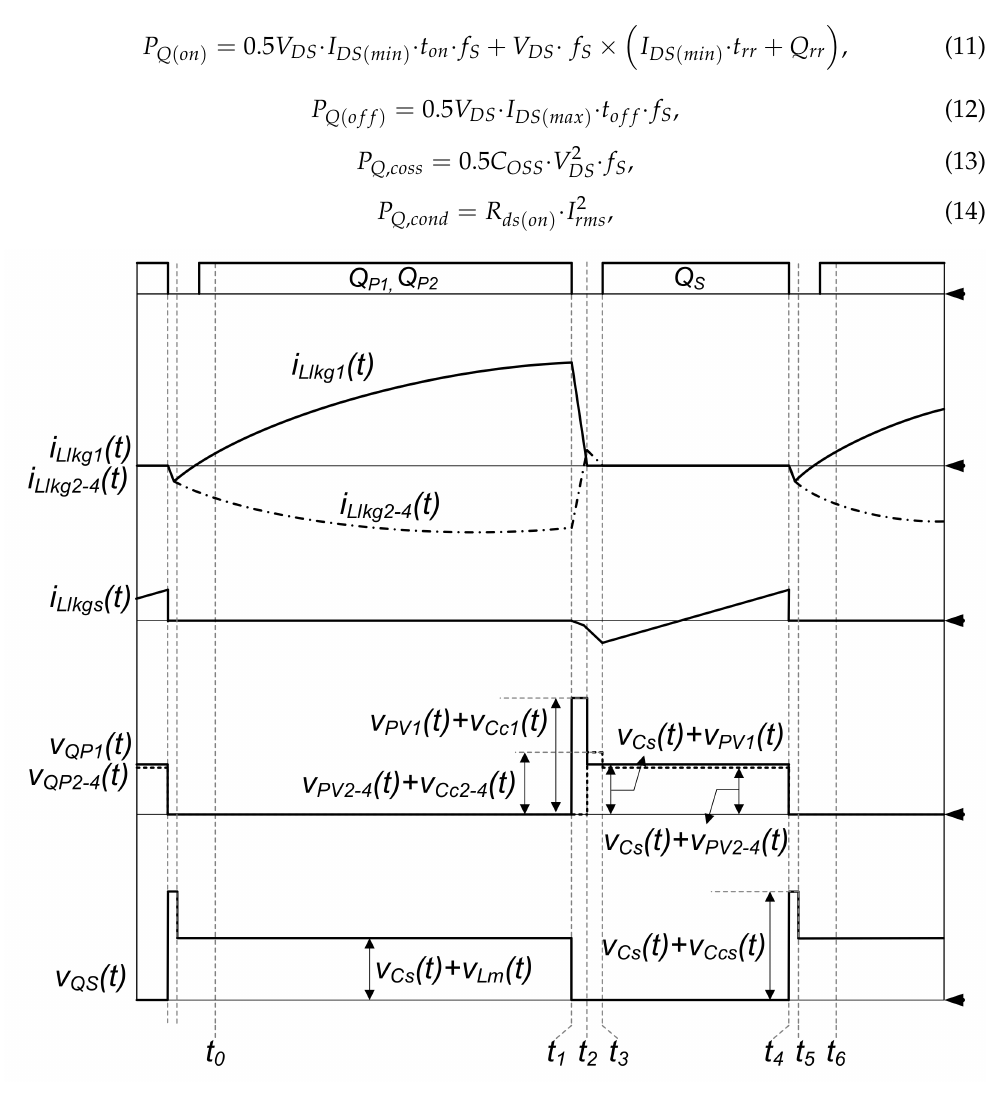
Figure 7. Leakage inductor current and switch voltage